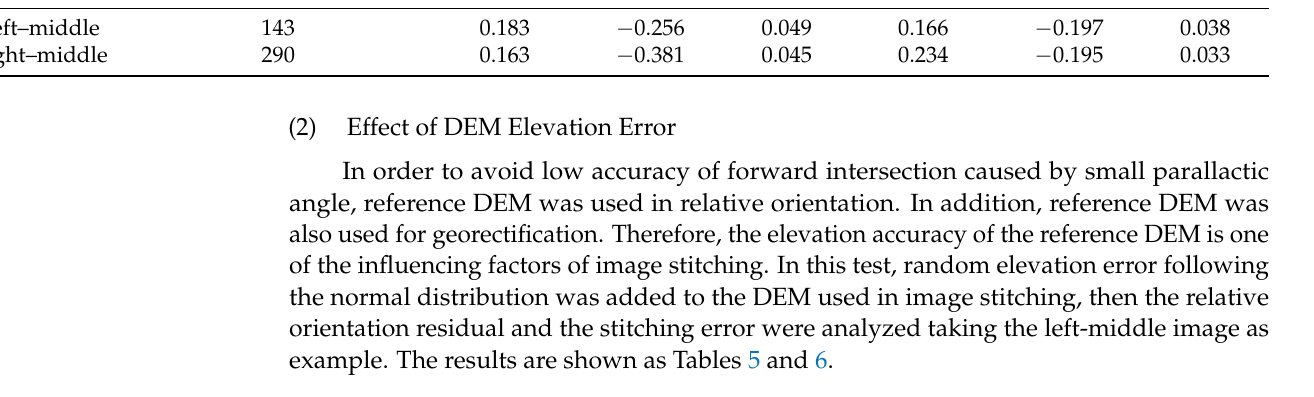
Table 4. Stitching error of EA-stable-1